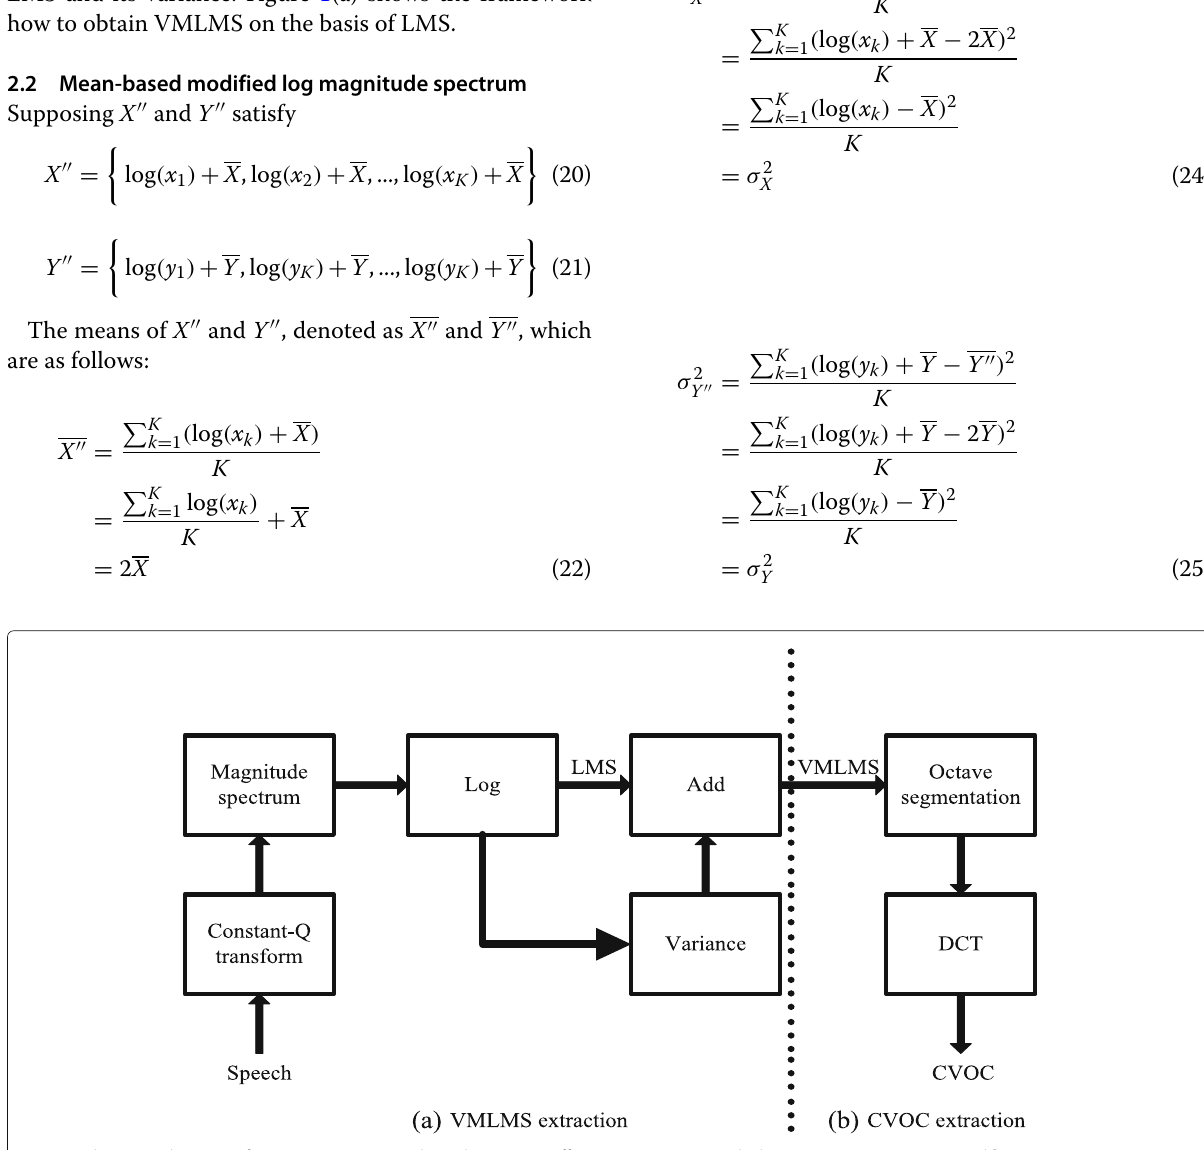
Fig. 1 Schematic diagram of constant-Q variance-based octave coefficients extraction, including a VMLMS extraction and b CVOC